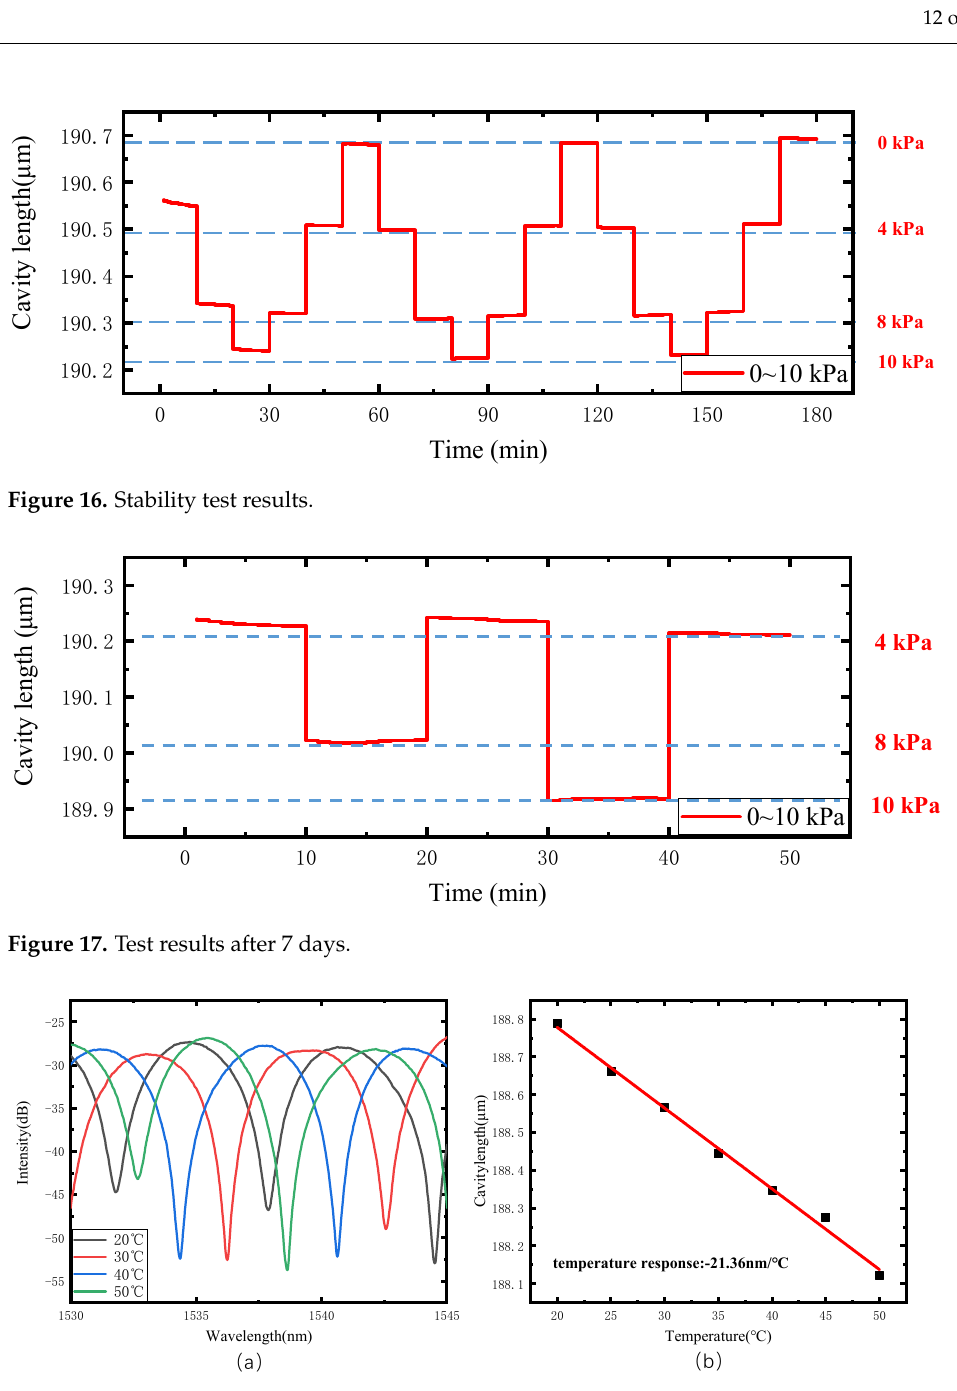
Figure 18. Temperature test results. ( a ) Temperature change response spectra and ( b ) temperature